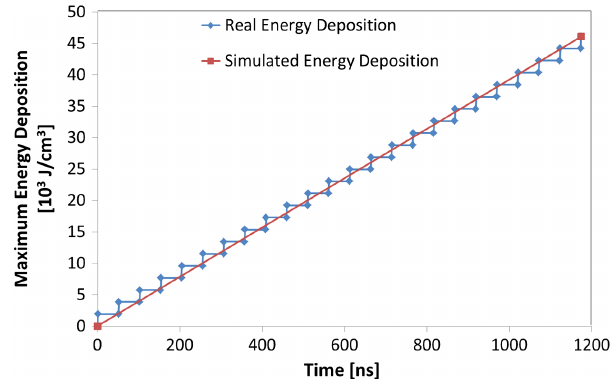
FIG. 18. Comparison of the real and simulated energy depo- sitions for Test 1 (24 bunches). The real energy deposition is performed bunch by bunch while in the simulations, the local temperature is taken to increase linearly with energy deposition (in time) due to the limited heat diffusion